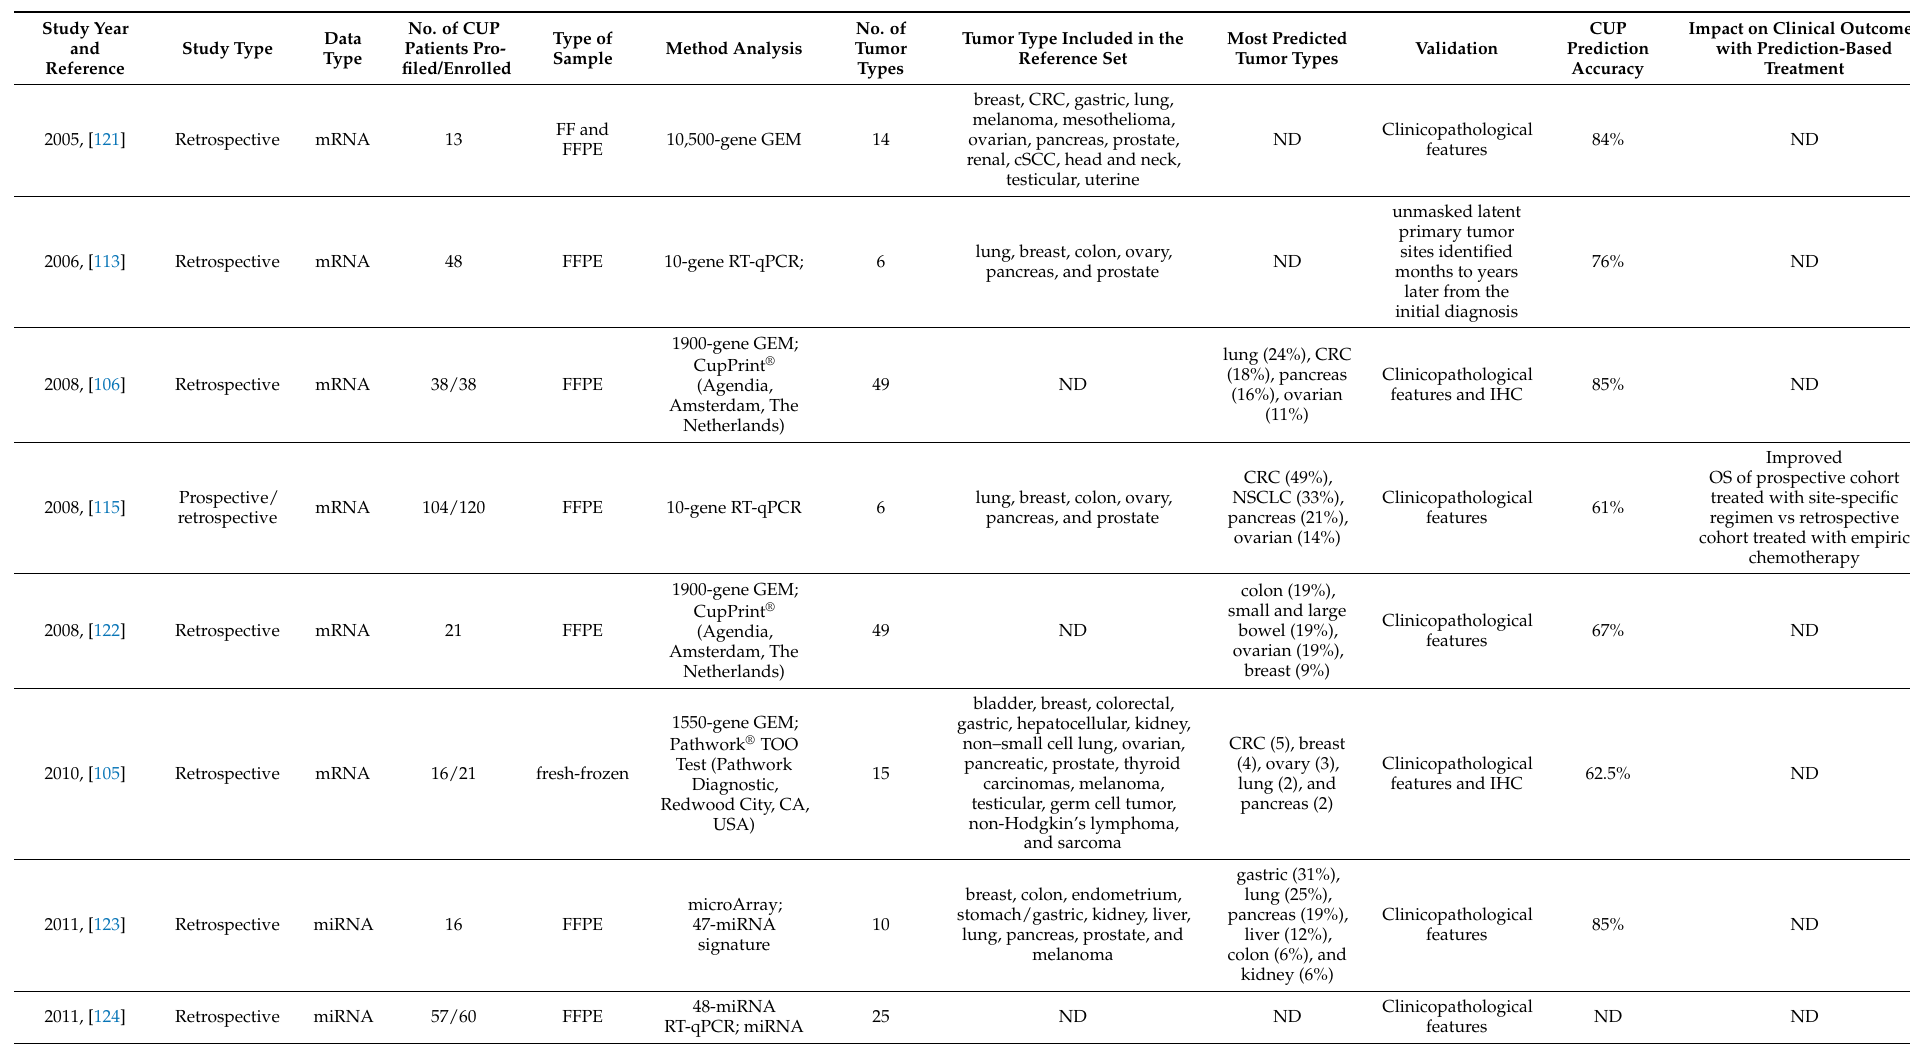
Table 2. Tissue-of-origin profiling assays applied on CUP